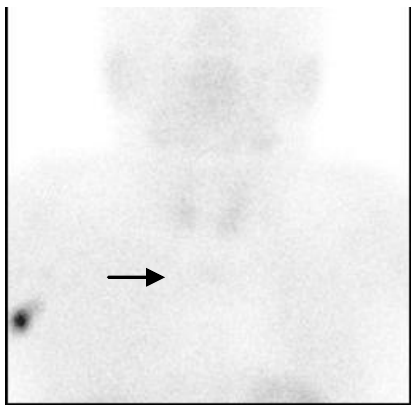
Fig. 3 99m Tc-MIBI 15min plane imaging of substernal heterotopic parathyroid glands (arrows)